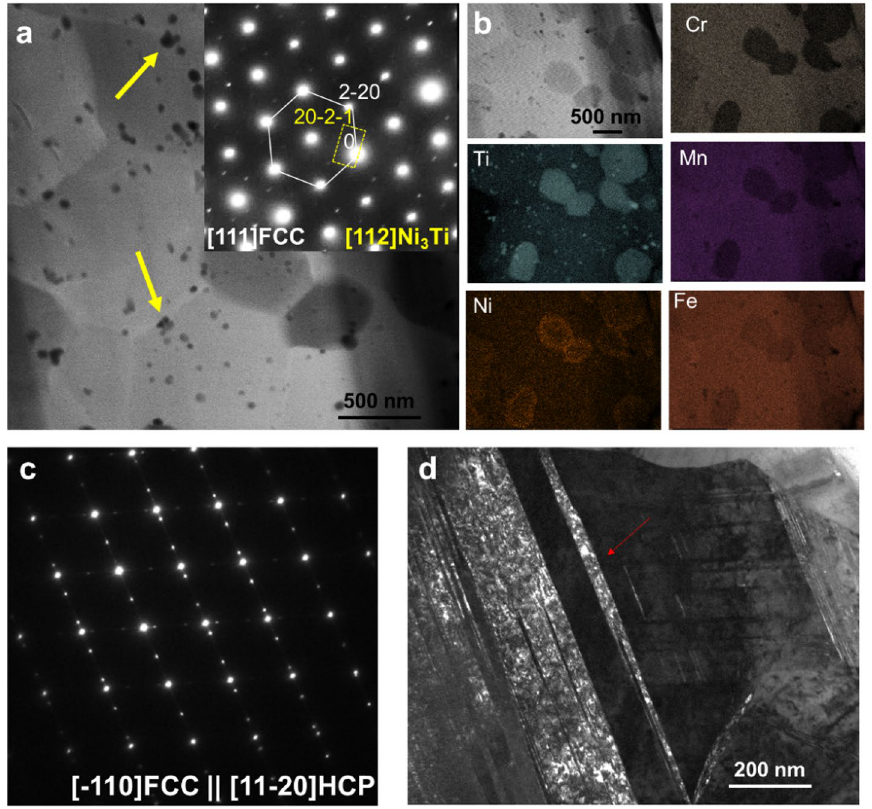
Figure 4. ( a ) HAADF-STEM image and corresponding SAED showing Ni 3 Ti precipitates indicated via yellow arrows after annealing and ( b ) corresponding TEM–EDS analysis revealing the presence of Ti and Ni rich precipitates. ( c ) Post-deformation SAED indicating the orientation relationship between < 110 > fcc and < 1120 > hcp and ( d ) BF-TEM showing transformation induced nano-scale HCP phases indicated via red